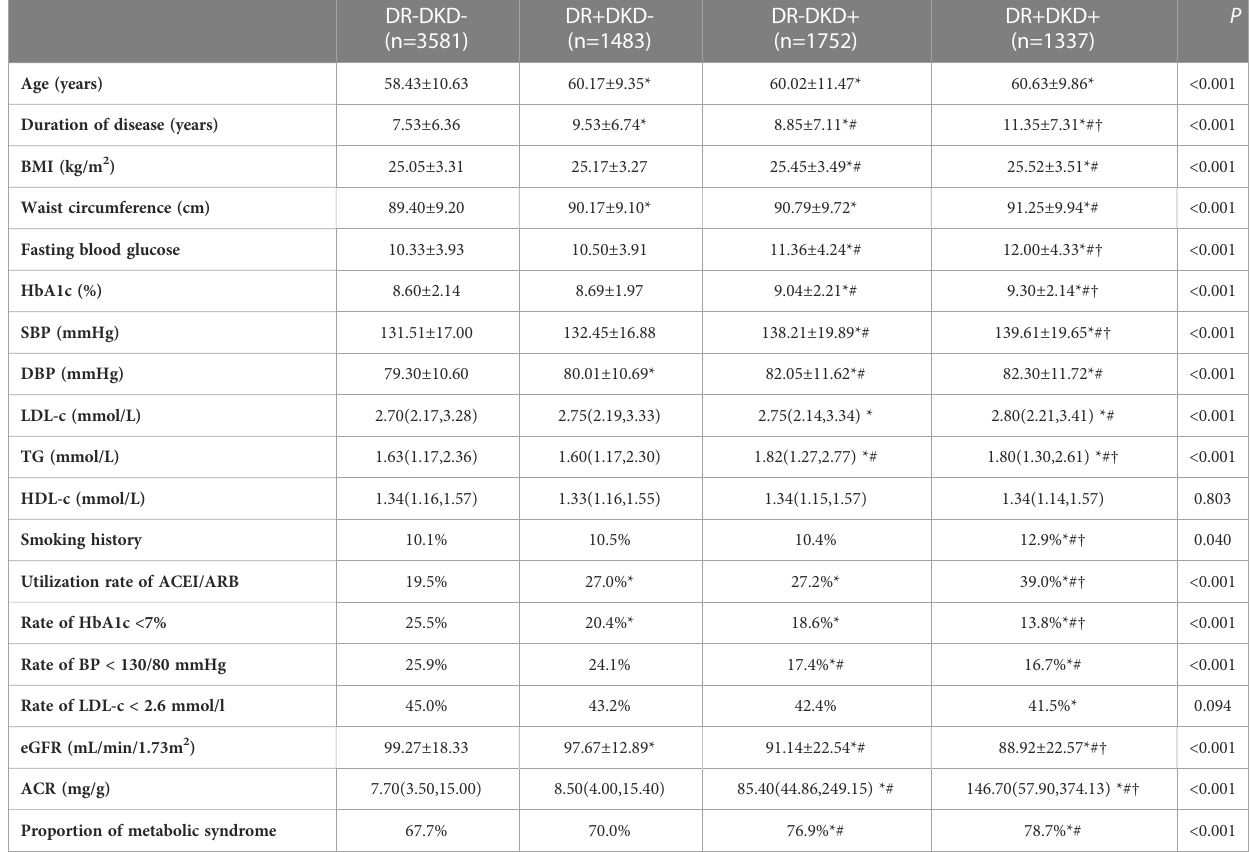
TABLE 2 Characteristics of different groups of patients with DR-DKD-, DR-DKD+, DR+DKD- and DR+DKD+.